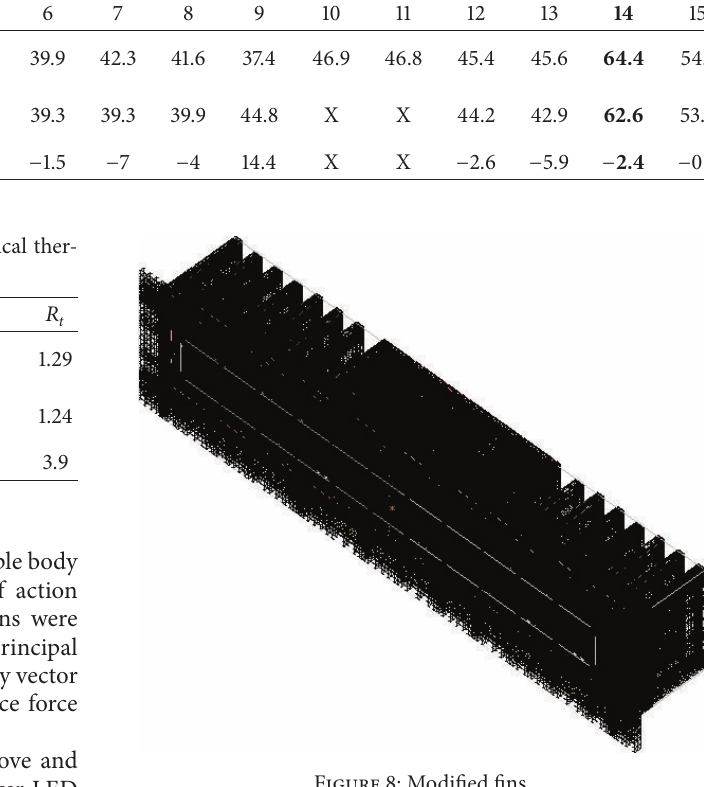
Figure 8: Modified